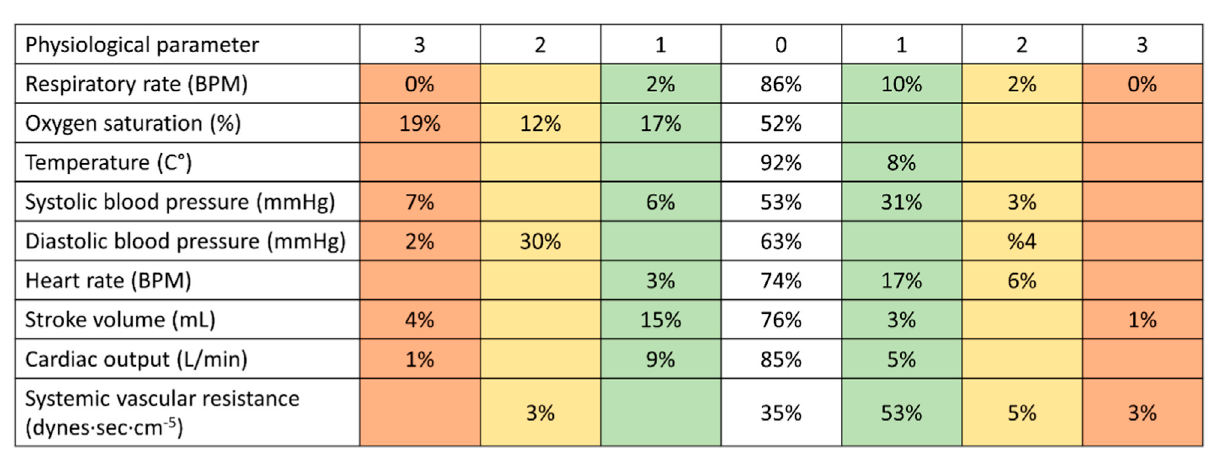
FIGURE 2 Analyzing data of patients using the new tool. After the de fi nitions of the new score were in place, we tested to see if they helped with thedetection of patient deterioration. When using the new tool, most of the readings were in the range of “ 0 ” and “ 1 ” scores (80% – 100% in the various physiological parameters), with only a low rate of “ 2 ” and “ 3 ” scores. RPM – respirations per minute; BPM – beats per minute.